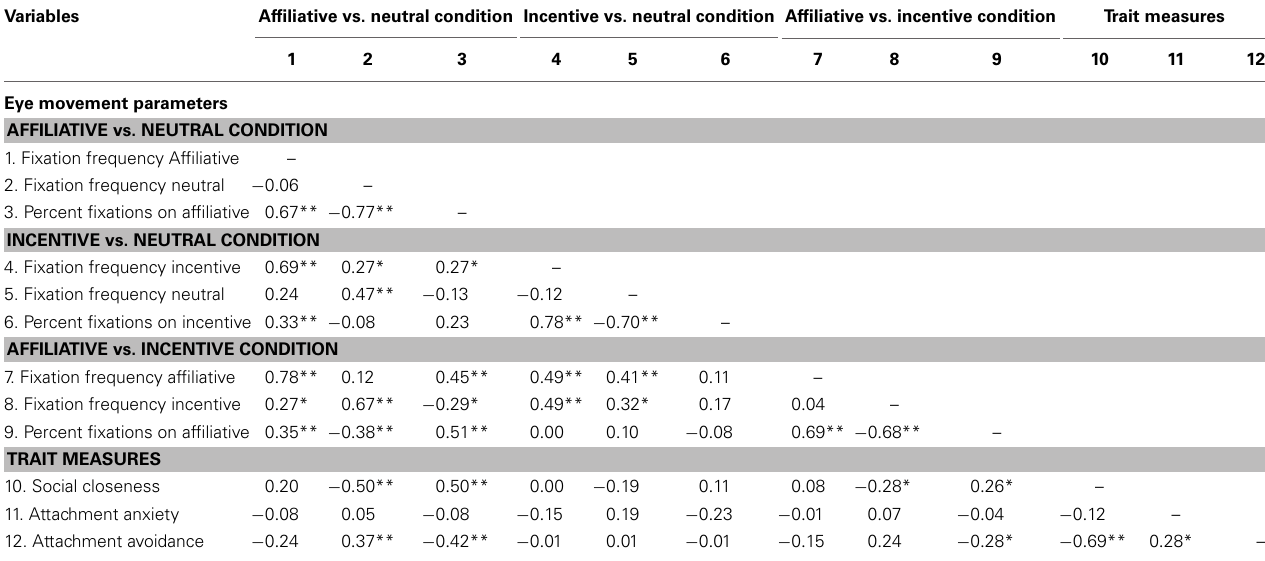
Table 2 | Correlations among variables. Variables